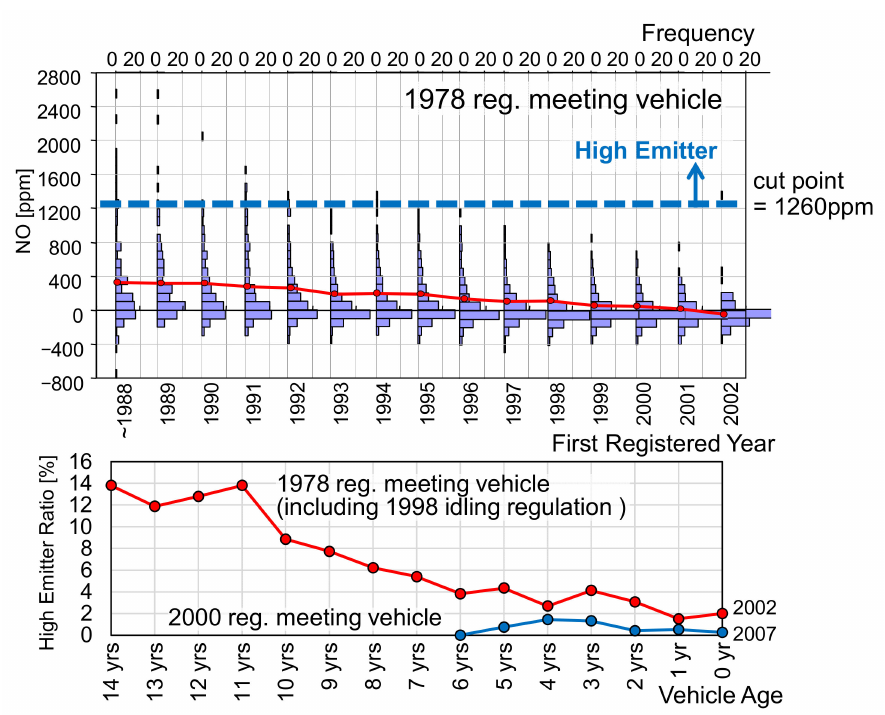
Figure 7. RSD measurement results and high emitter ratio of passenger